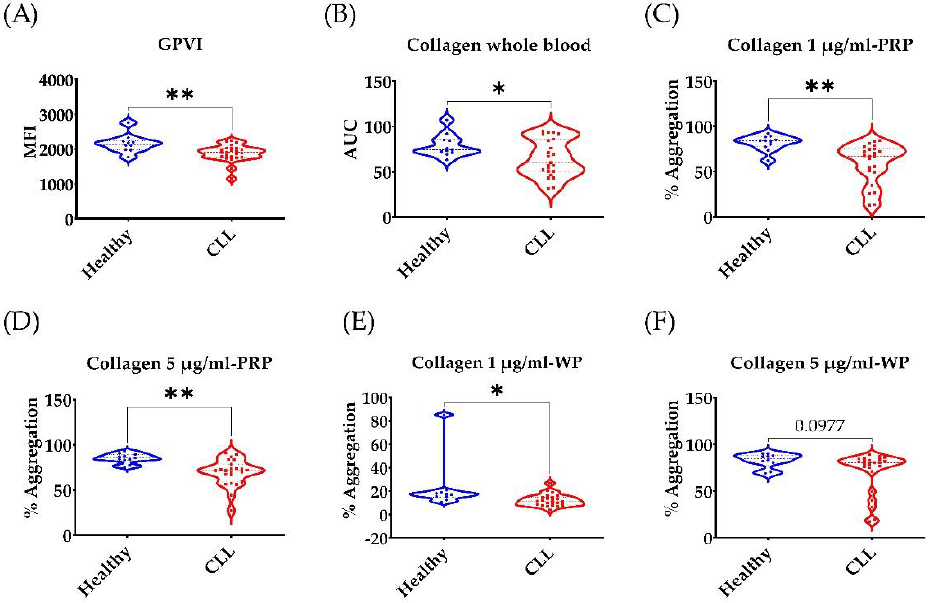
Figure 1. Low GPVI expression and collagen response in CLL patients compared to age-matched healthy volunteers . ( A ) Geometrical mean fluorescence intensity of GPVI-AF647 in PRP obtained from untreated CLL patients compared to age-matched healthy volunteers. ( B – F ) Platelet function analysis in whole blood ( B ), PRP ( C , D ) and washed platelets (WP) ( E , F ) in response collagen. * p < 0.05 , ** p < 0.01; n = 23 CLL patients and 11 healthy volunteers. Platelet aggregation in PRP was measured by LTA. Whole blood aggregation was measured by MEA using collagen 3.2 µg/mL